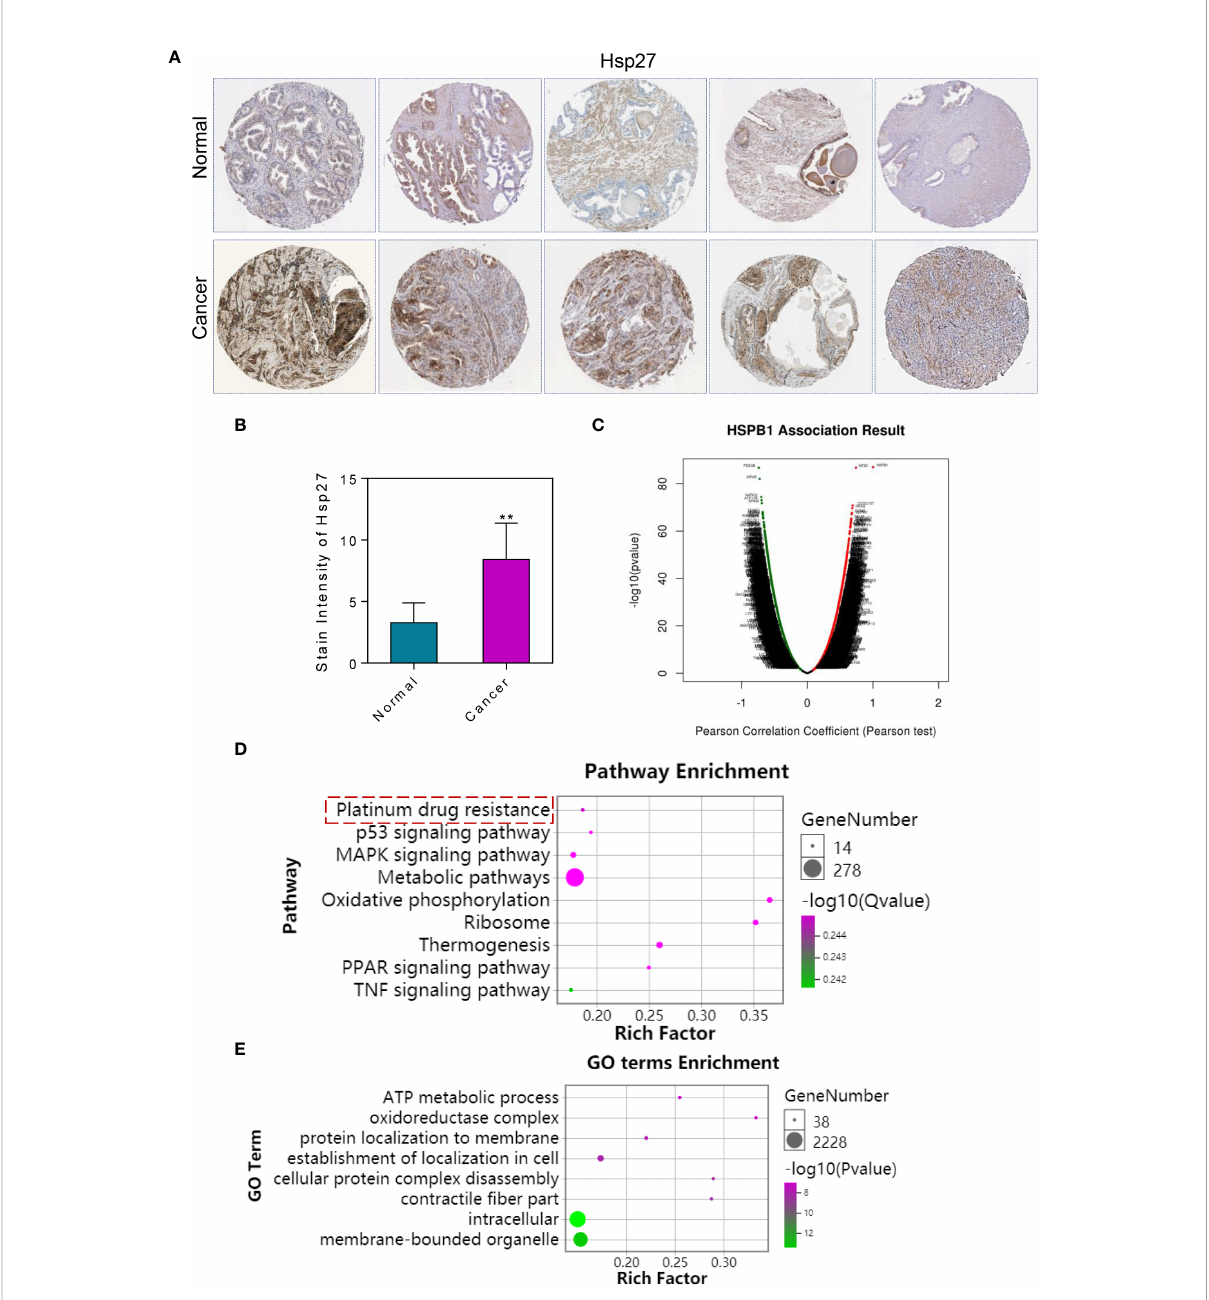
FIGURE 1 Expression of Hsp27 in prostate cancer and functional enrichment analysis of its co-expressed genes. (A) The expression changes of Hsp27 were analyzed using the human protein atlas database. Immunohistochemistry showed high expression of Hsp27 in the cytoplasm of tumor cells. 4×. (B) Immunohistochemical expression of Hsp27 in prostate cancer. (C) Analysis of co-expressed genes of Hsp27 in prostate cancer. Red indicates co-expression of positively correlated genes. Green indicates co-expression of negatively correlated genes. (D) KEGG enrichment analysis of Hsp27 co-expressed genes. (E) GO enrichment analysis of Hsp27 co-expressed genes. The results of enrichment analysis showed that Hsp27 and its co-expressed genes may be related to tumor drug resistance. **P <0.01 by two-tailed Student ’ s